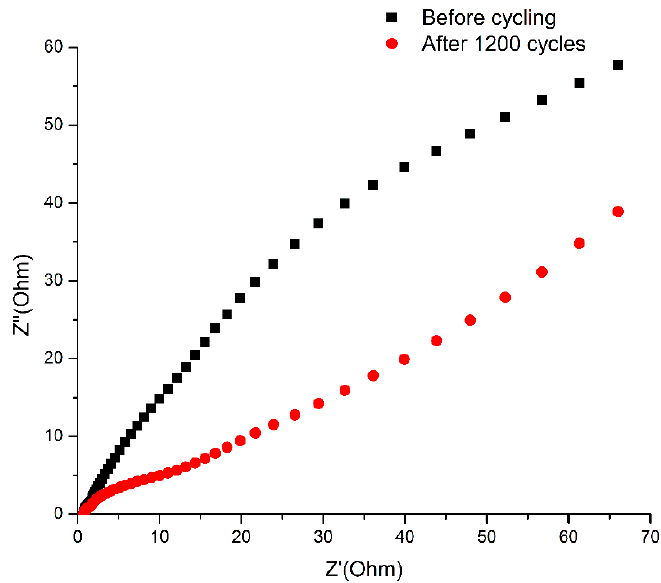
Figure 6. Nyquist plots of the Ni@Cu-MOF before and after 1200 cycles. Electrochemical properties of the Ni@Cu-MOF/activated carbon (AC) asymmetric supercapacitor.